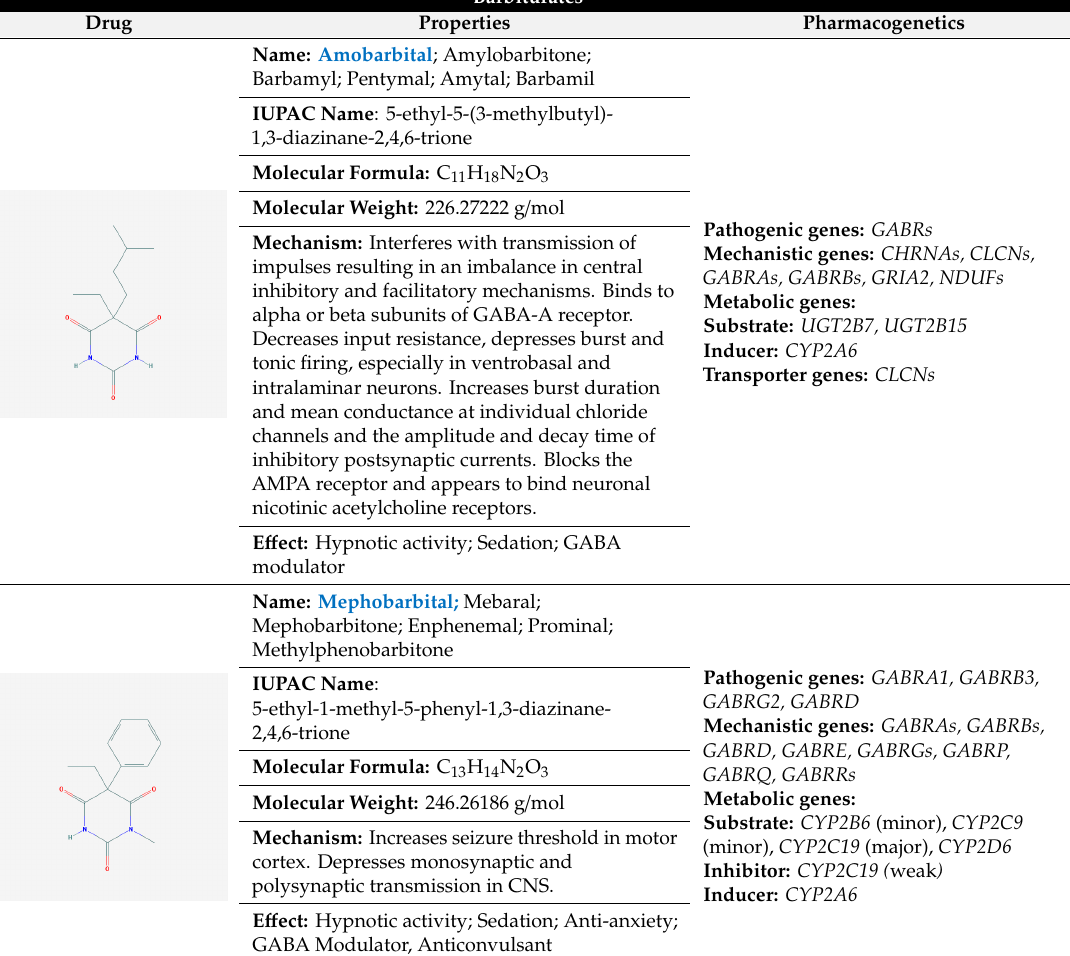
Table 5. Pharmacological profile and pharmacogenetics of selected anxiolytics, sedatives, and hypnotics.